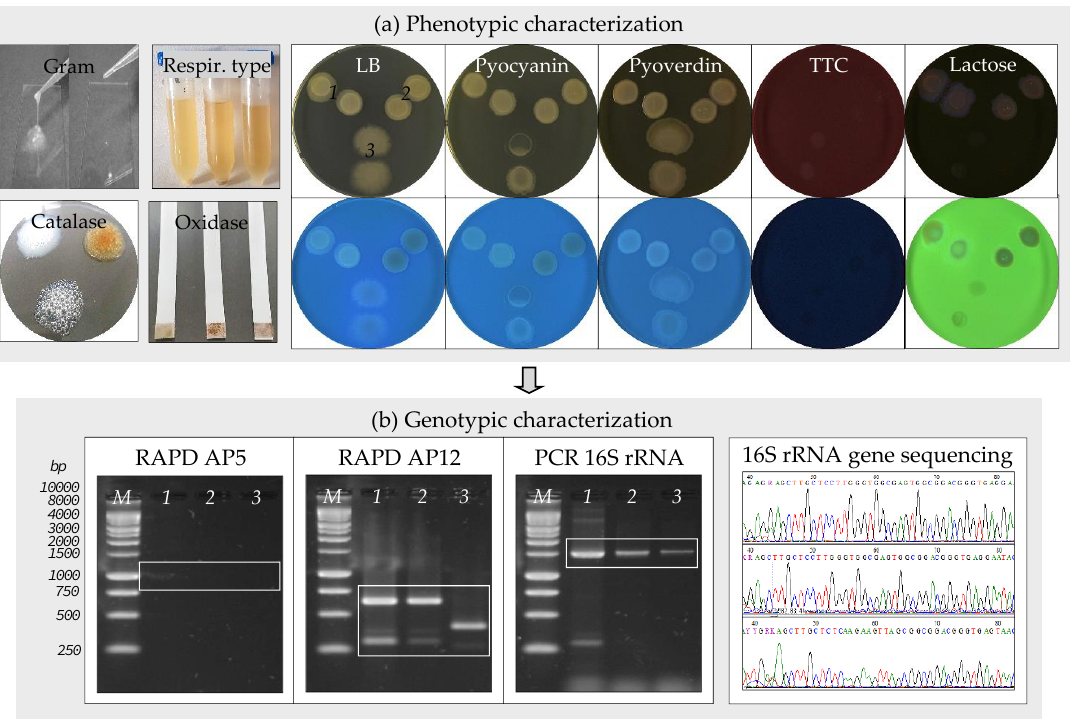
Figure 2. Bacteria identification through phenotypic and genotypic characteristics. ( a ) Phenotypic